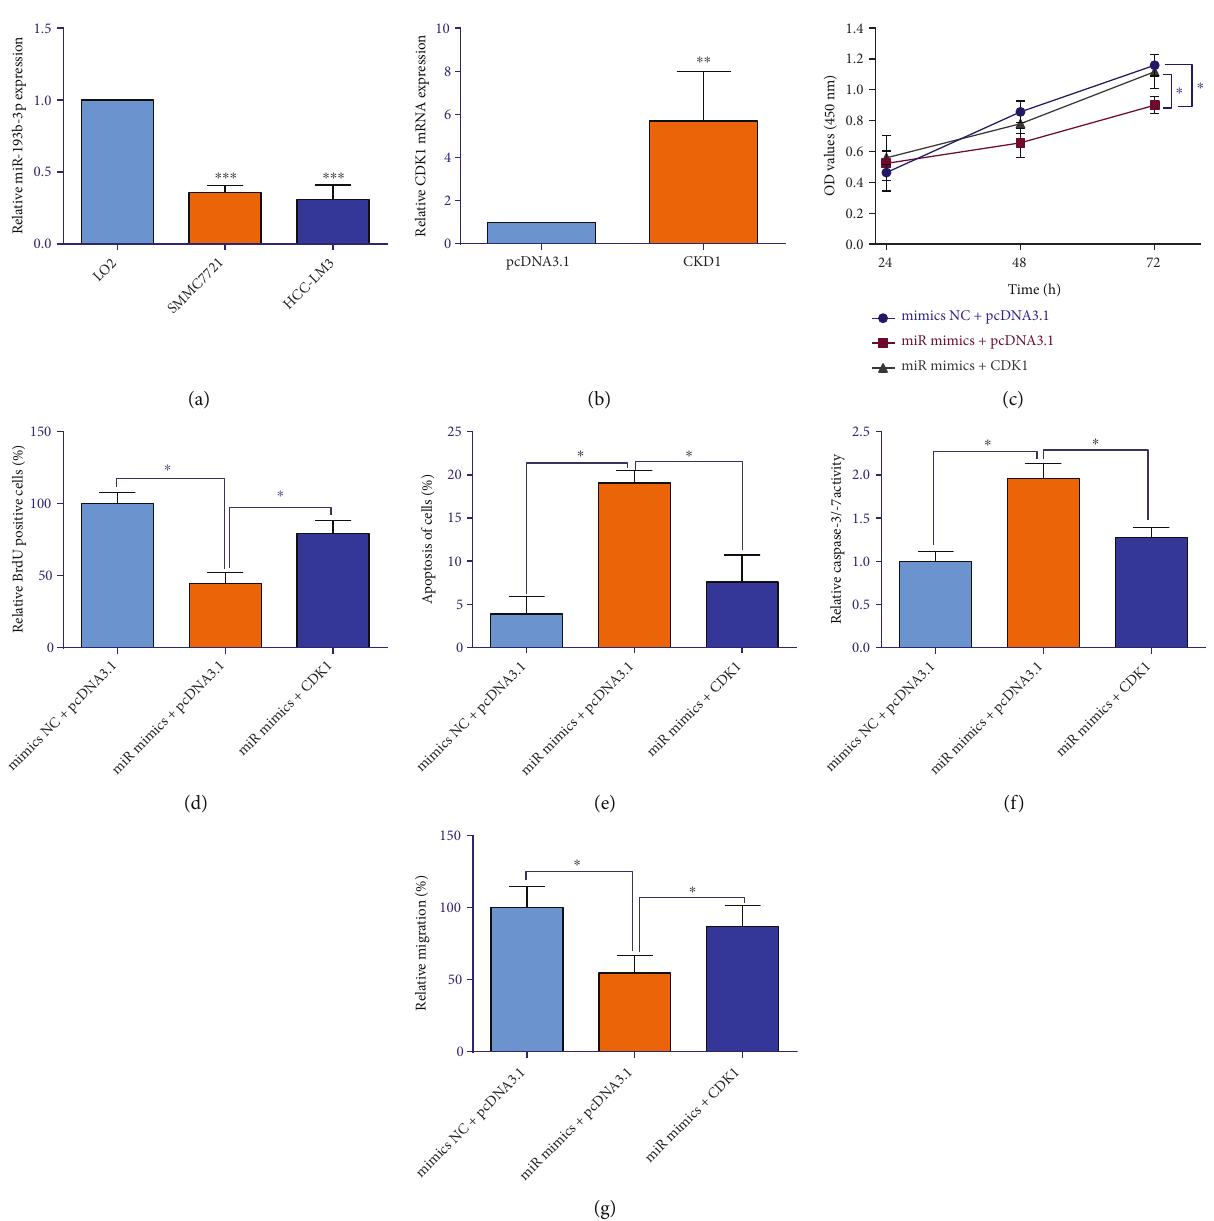
Figure 11: CDK1 overexpression attenuated miR-193b-3p-modulated actions on the HCC cell proliferation and migration. (a) Relative expression of miR-193b-3p in LO2, SMMC7721, and HCC-LM3. (b) SMMC7721 cells were transfected with pcDNA3.1 or pcDNA3.1- CDK1. (c) – (f) SMMC7721 cells were co-transfected with miRNAs and plasmids, and at 24 hours after co-transfection, (c) cell viability of SMMC7721 cells; (d) cell proliferation of SMMC7721 cells; (e) cell apoptosis of SMMC7721 cells as determined by TUNEL assay; (f) the caspase-3/-7 activities of SMMC7721 cells; and (g) cell migration of SMMC7721 cells. N = 3 ; * P < 0 : 05 , ** P < 0 : 01 , and *** P < 0 : 001